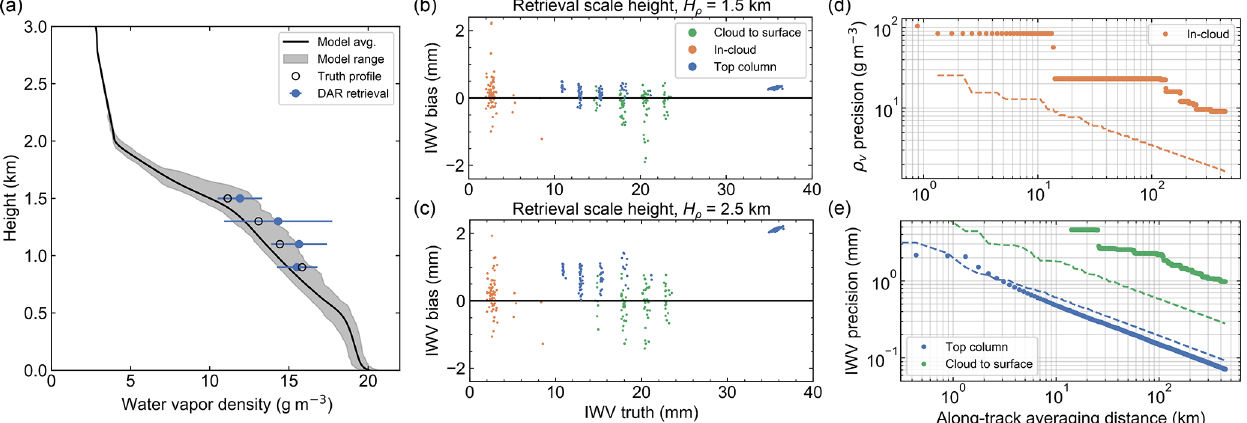
Figure 7. BOMEX DAR retrieval results. (a) Comparison of mean-retrieved and model in-cloud humidity profiles, depicted as in the GATE case (Fig. 3a). (b–c) Retrieved IWV bias vs. truth for assumed humidity scale heights of 1.5 and 2.5km. (d–e) Retrieval precision scaling with along-track averaging, where the in-cloud results correspond to a retrieval height of